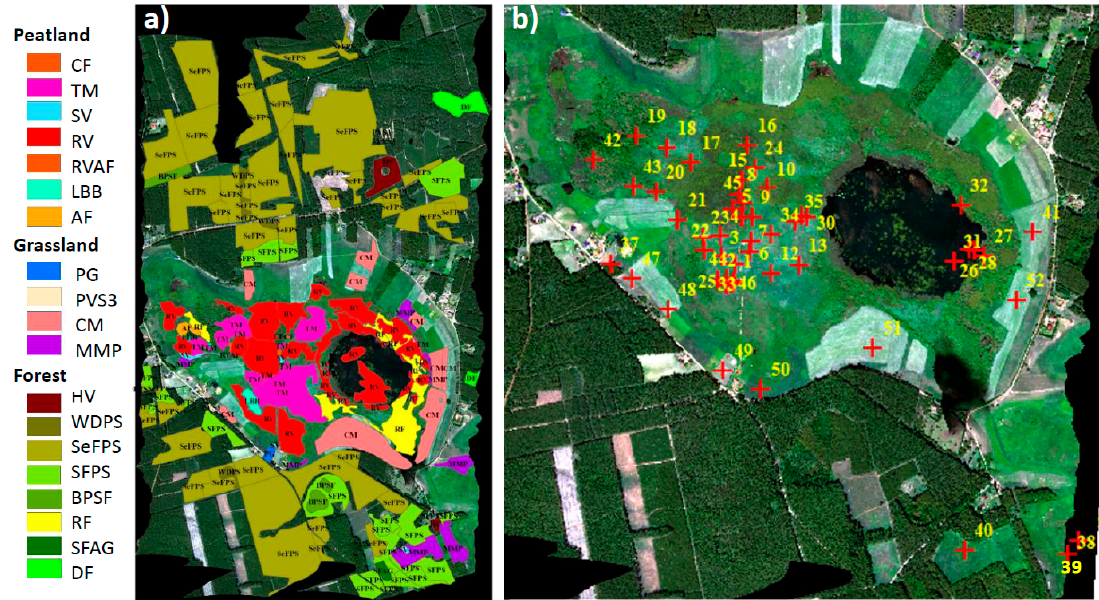
Figure 3. Boundaries of 158 ROIs identified within the HyPlant image and categorized into 19 unique vegetation groups ( a ); and location of 52 plots inside the peatland and its boundaries, categorized into 20 unique plant communities ( b ). Detailed characteristics of the plant communities within the 52 plots are presented in Table S1 (supplementary table).